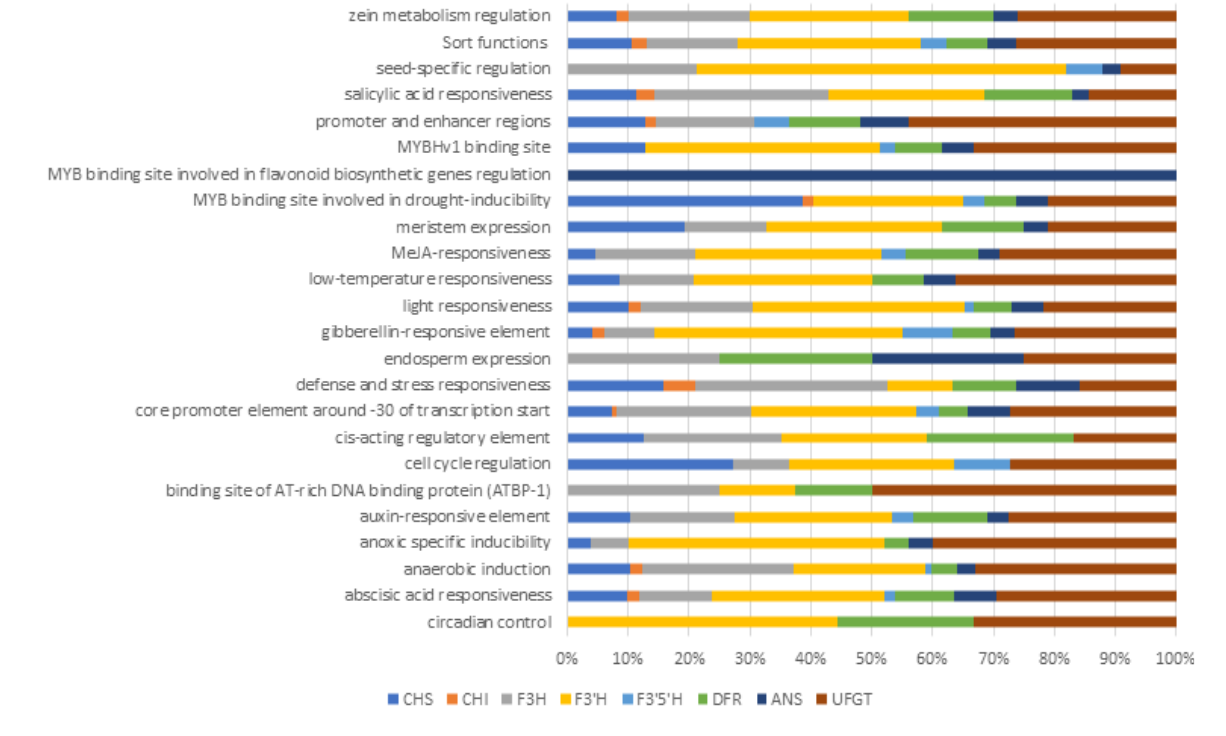
Figure 6. Most commonly occurring cis- acting regulatory elements in target genes.